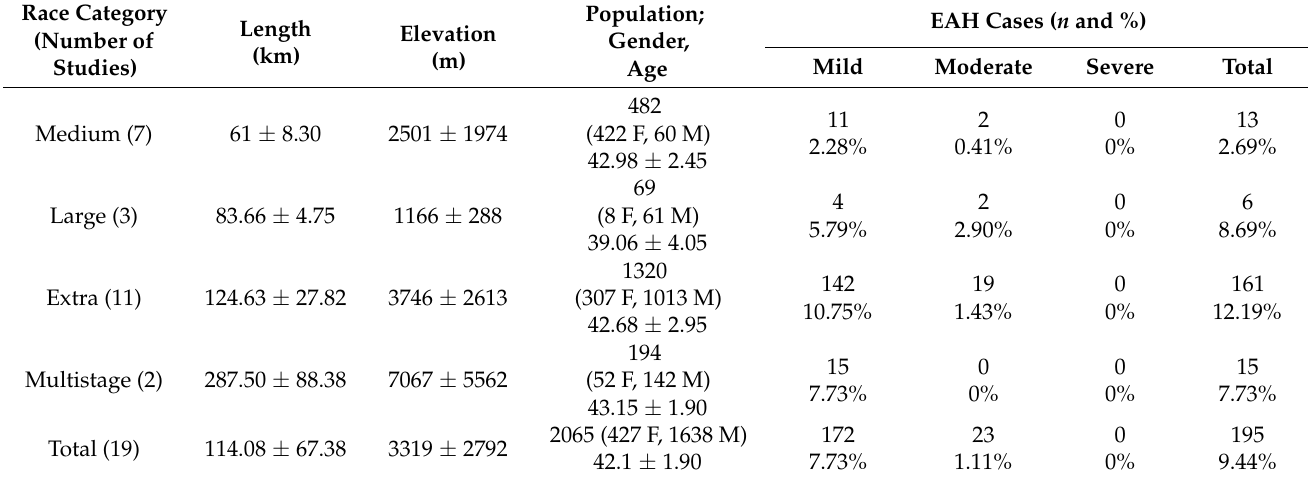
Table 4. EAH cases sorted by the race category.